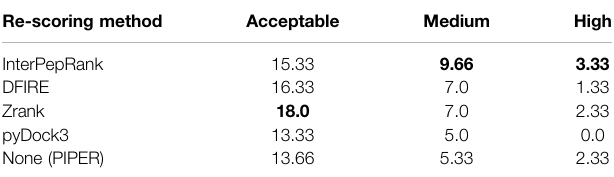
TABLE 3 | For how many of the targets in the Expanded Analysis set the modi fi ed PIPER-FlexPepDock pipeline produced models of the different quality measures among the top 10 results. As Rosetta FlexPepDock is a Monte-Carlo based approach, the part of the pipeline utilizing the FlexPepDock protocol and onwards was run in triplicates and the results averaged.Note that Acceptable means any model of at least acceptable quality (same for Medium). Highest number per column marked in